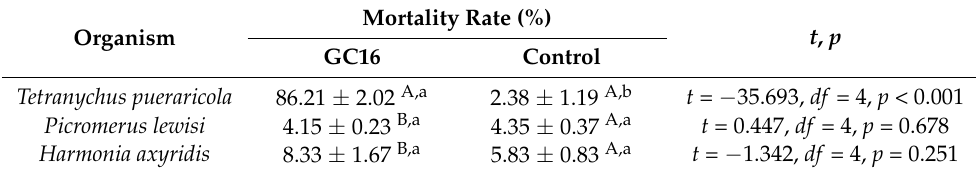
Table 4. The mortality rates (Mean ± SE) of target organism ( Tetranychus pueraricola ) and non-target organisms ( Picromerus lewisi, Harmonia axyridis ) after treating with GC16 vs. Control (water). Mortality Rate (%) t , p Organism GC16 Control Tetranychus pueraricola 86.21 ± 2.02 A,a 2.38 ± 1.19 A,b t = − 35.693, df = 4, p < 0.001 Picromerus